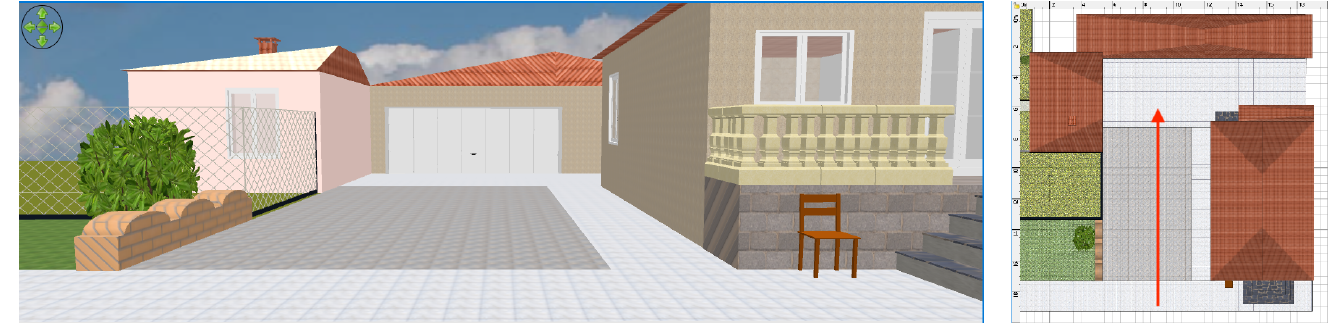
Figure 9. Three-dimensional rendering of the house backyard involved in the environmental perception evaluation. On the right, the walking path is